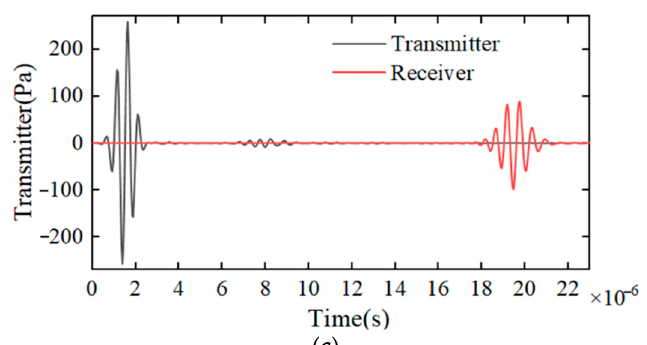
Figure 5. ( a ) 10 mm diameter ultrasonic transmission and reception signal; ( b ) 15 mm diameter ul- trasonic transmission and reception signal; ( c ) 20 mm diameter ultrasonic transmission and reception signal.